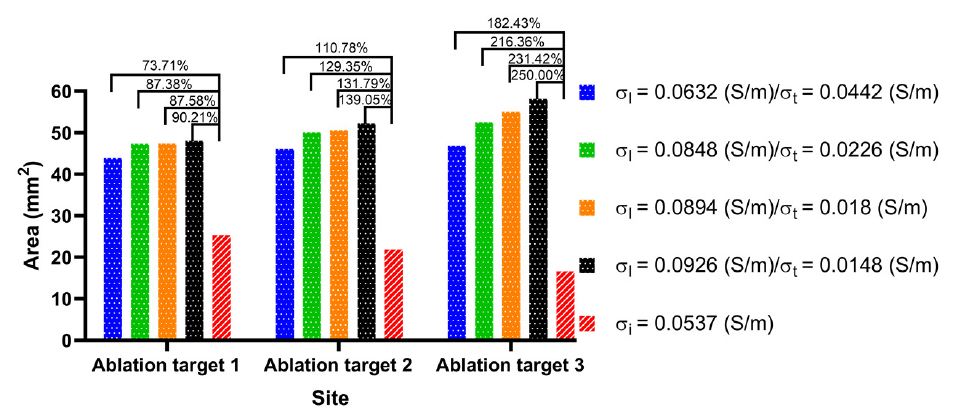
Figure 8. The statistical results of the size of the surface ablation area under the condition of the PFA amplitude is 1000 V at three ablation targets, where the numbers between the top of the bars represent the absolute percentage difference in the size of the surface ablation area between AC and IC in the four electrical conductivity groups, respectively.